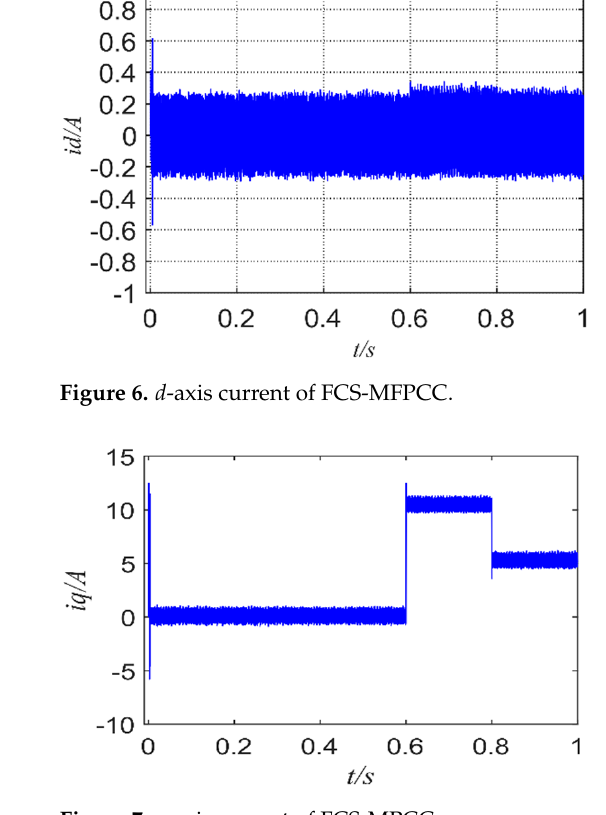
Figure 7. q -axis current of FCS-MPCC.